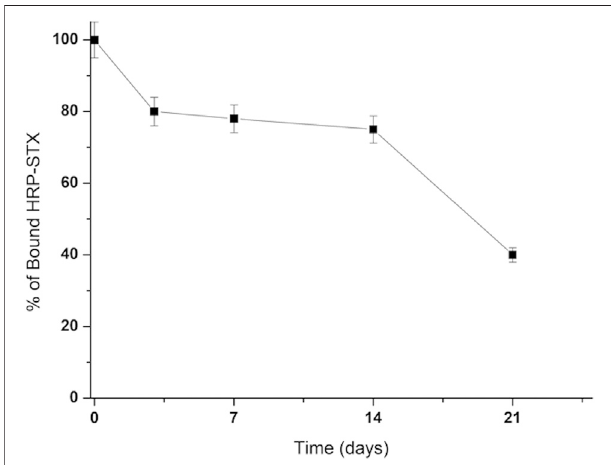
FIGURE 4 | Stability of the Vmh2-ScFv STX – functionalized MBs.